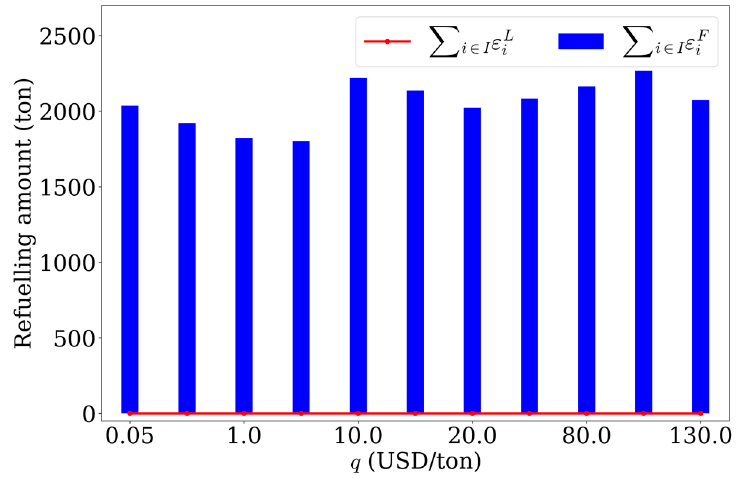
Figure 2. Comparison of